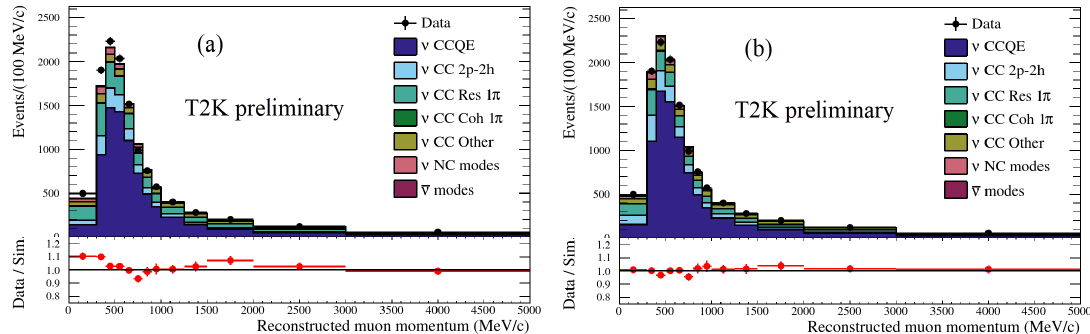
Figure 4. The muon spectrum in ND280 event samples enhanced in quasi-elastic charged current interactions is compared to the model expectations for the ( a ) nominal systematic parameters and ( b ) optimized systematic parameters. The optimization takes into account constraints from external data.